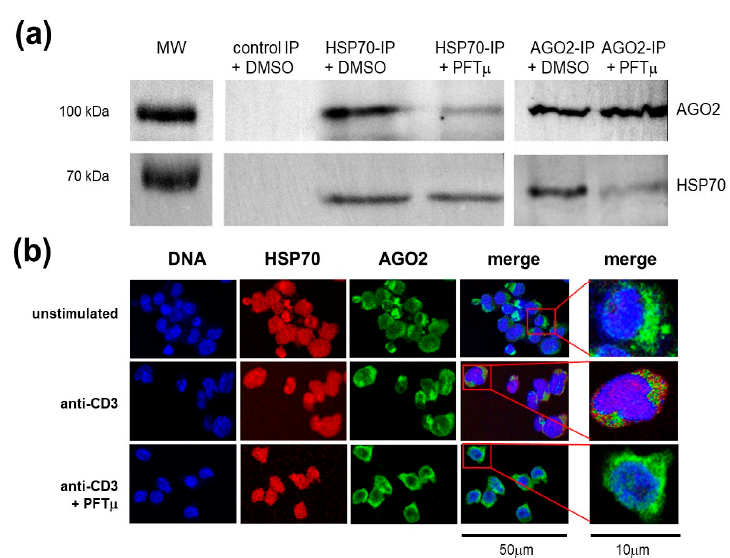
Figure 4. HSP70 is associated with Argonaute 2 protein (AGO2) and RNA-induced silencing complex in EL4 TCR + cells following a TCR stimulation. ( a ) Western blot analysis of AGO2 and HSP70 proteins in the anti-HSP70, in the anti-AGO2 or in the control Ig precipitate of the EL4 TCR + cells that were stimulated with anti-CD3 in the presence of PFT μ (10 μ M) or with a control (DMSO) with a parallel separation of the MW marker. Representative results from two to three independent experiments are shown. ( b ) EL4 TCR + cells were cultured for 24 h with or without anti-CD3 stimulation, or with anti- CD3 stimulation in the presence of PFT μ (10 μ M) or with a control (DMSO) and assayed for localization of HSP70 and AGO2 proteins by immunofluorescence. Red color represents HSP70 staining, green color represents AGO2 staining whereas blue color demonstrates DAPI staining of the nucleus (scales as depicted). Representative results from two to three independent experiments are shown.